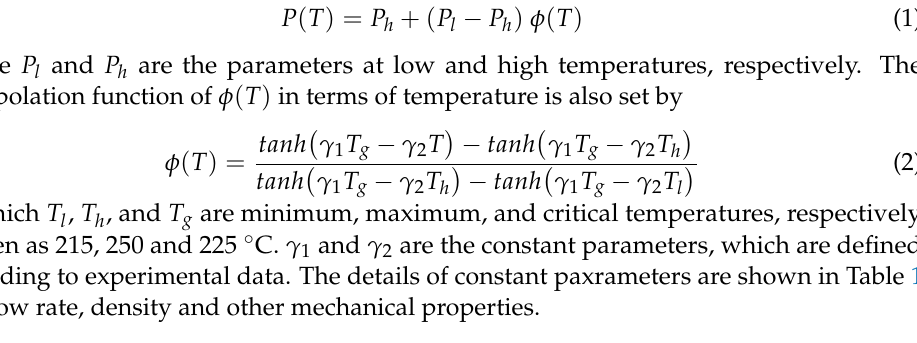
Table 1. The material constant parameters.